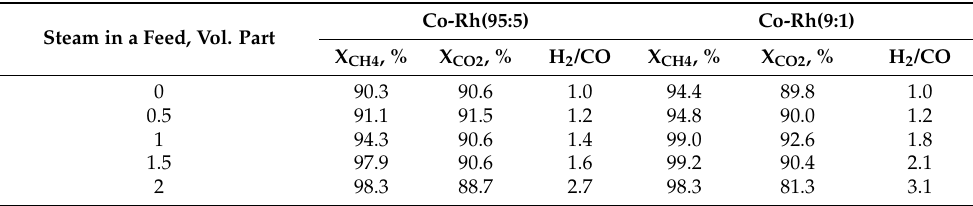
Table 4. Effect of steam and Rh amount on CO 2 -CH 4 conversion over the 5%Co-Rh/Al 2 O 3 catalysts at CO 2 :CH 4 = 1:1, t = 700 ◦ C, P = 1 atm, GHSV = 1000 h − 1 . Steam in a Feed, Vol.